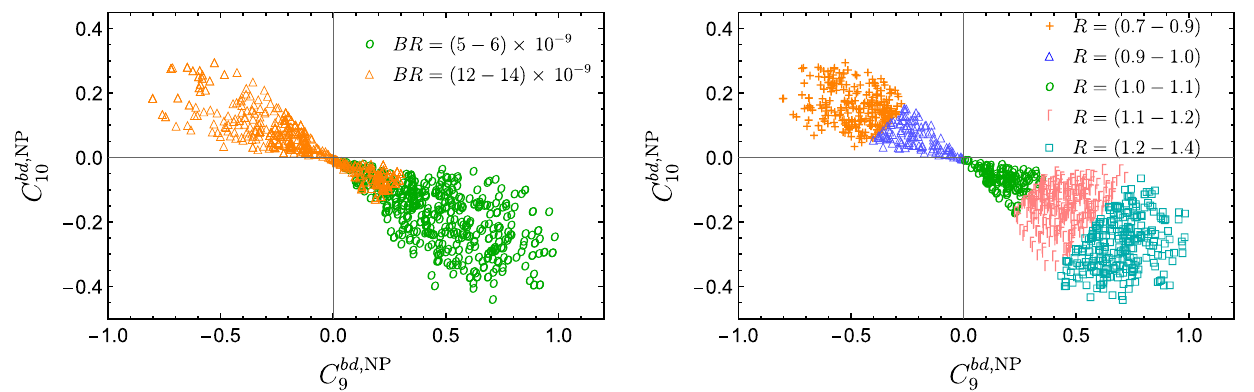
Fig. 4 Integrated values of the branching ratio of B s → ¯ K ∗ μ + μ − (left panel) and the LFUV ratio R ( s ) , C bd , NP space of ( C bd , NP 9 10